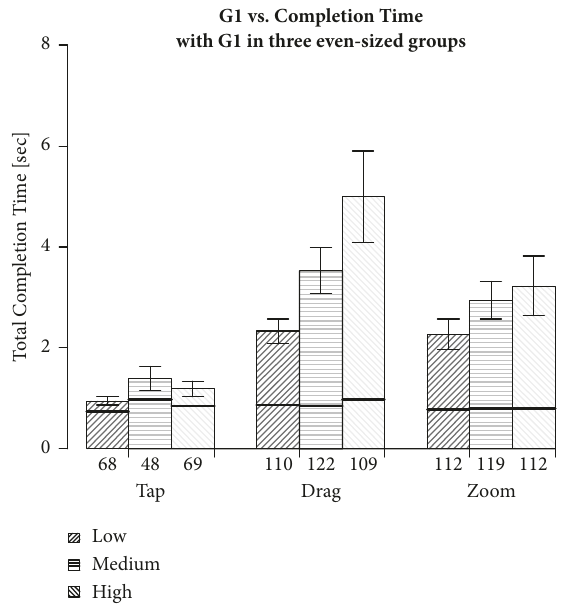
Figure 25: Completion time for the three task types depending on RMS of angular speeds ( ∘ /s) for G2 (yaw). The number of samples is provided below the histograms. Horizontal bars denote the average time to first